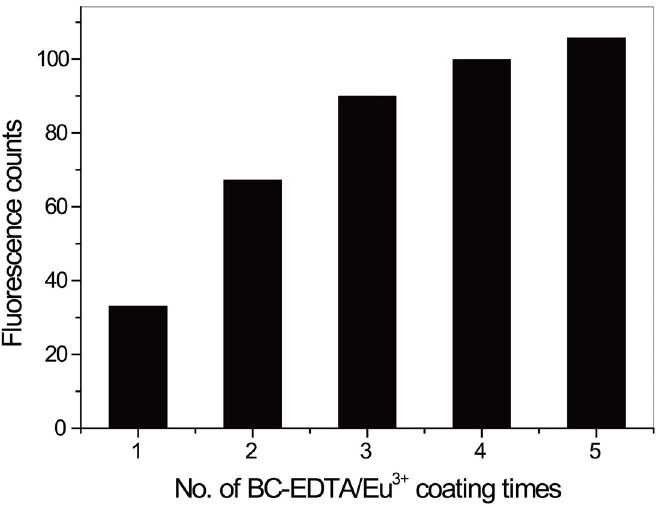
Fig 7. Relationship between fluorescence intensity of nanosphere and coating times. BC-EDTA/Eu 3 + -nanosphere was diluted in 0.05 mol/L carbonate buffer, pH9.5, with the concentration of